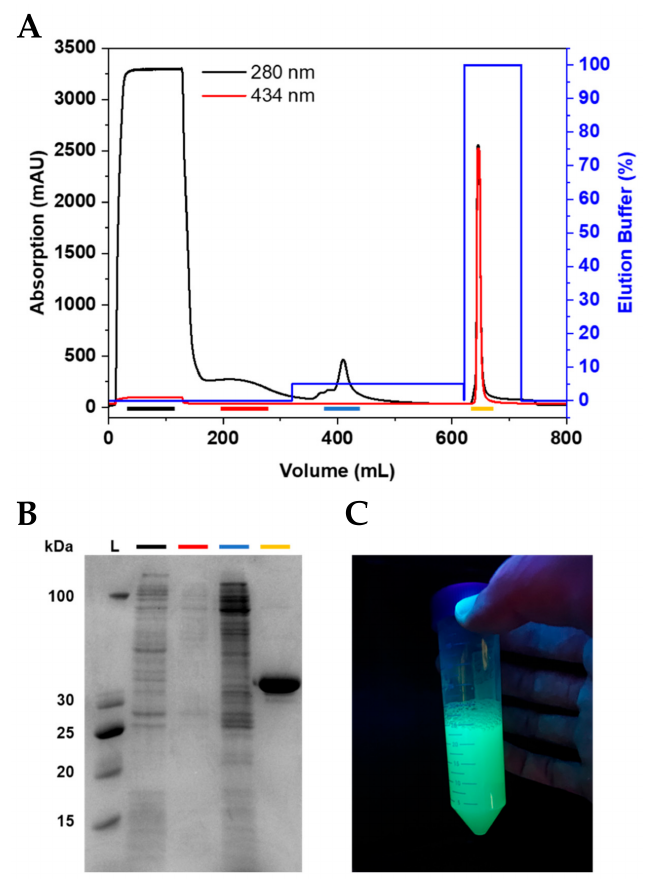
Figure 2. Purification of CyPet-BCL11B 42-94 . ( A ) Chromatogram of CyPet-BCL11B 42-94 purification using IMAC. ( B ) Corresponding SDS-PAGE showing the collected fractions. The flow-through (black) shows E. coli proteins that do not bind to the column. The wash (red) contains loosely bound proteins. The wash step with 5% elution buffer (blue) is crucial to obtain the highly pure fluorescently tagged zinc finger domain (yellow). ( C ) Purified CyPet-BCL11B 42-94 under UV